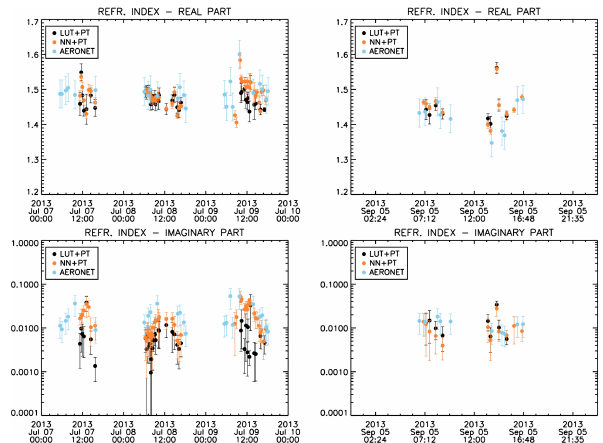
Figure 7. Time series of the real (above) and imaginary part (below) of the (AOT-weighted) refractive index retrieved by the LUT + PT scheme (black circles), the NN + PT scheme (orange circles), and the AERONET almucantar level 1.5 product (sky-blue circles): be- tween 7 and 9 July 2013 (left) and on 5 September 2013